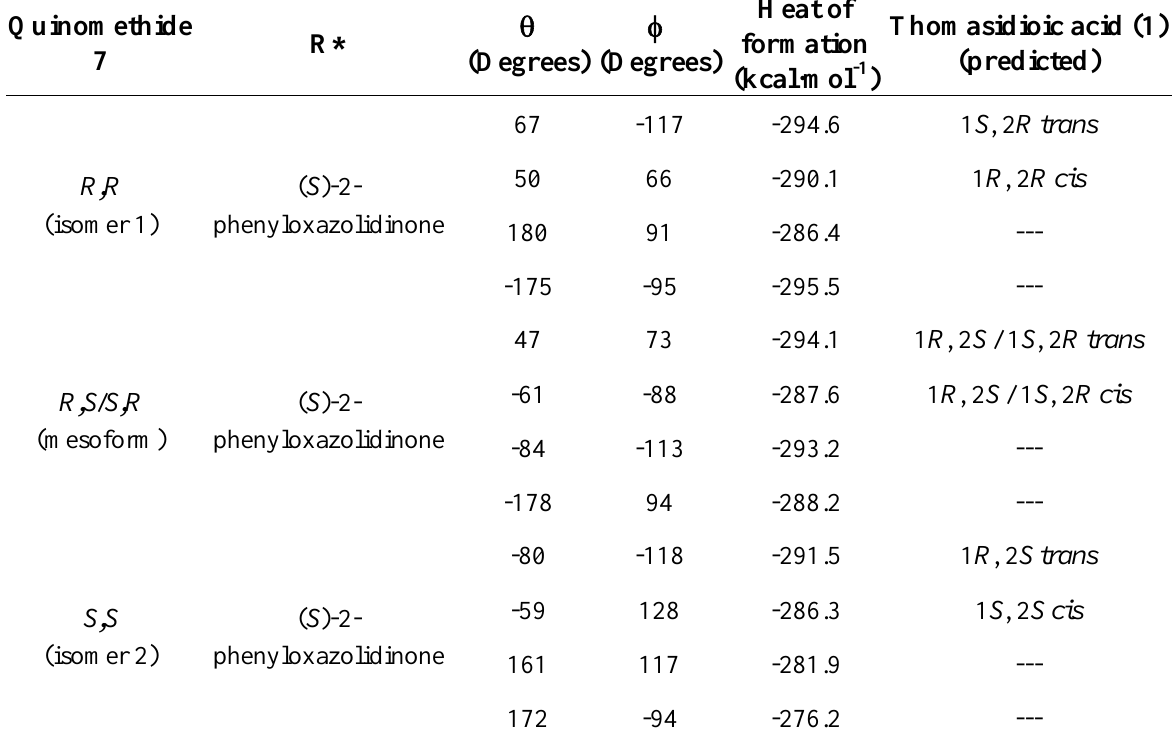
Table 4 . Energy minima on the PES of the quinomethides 7 calculated as a function of the θ and φ dihedral angles (see Scheme 3) at the semiempirical PM3 level of